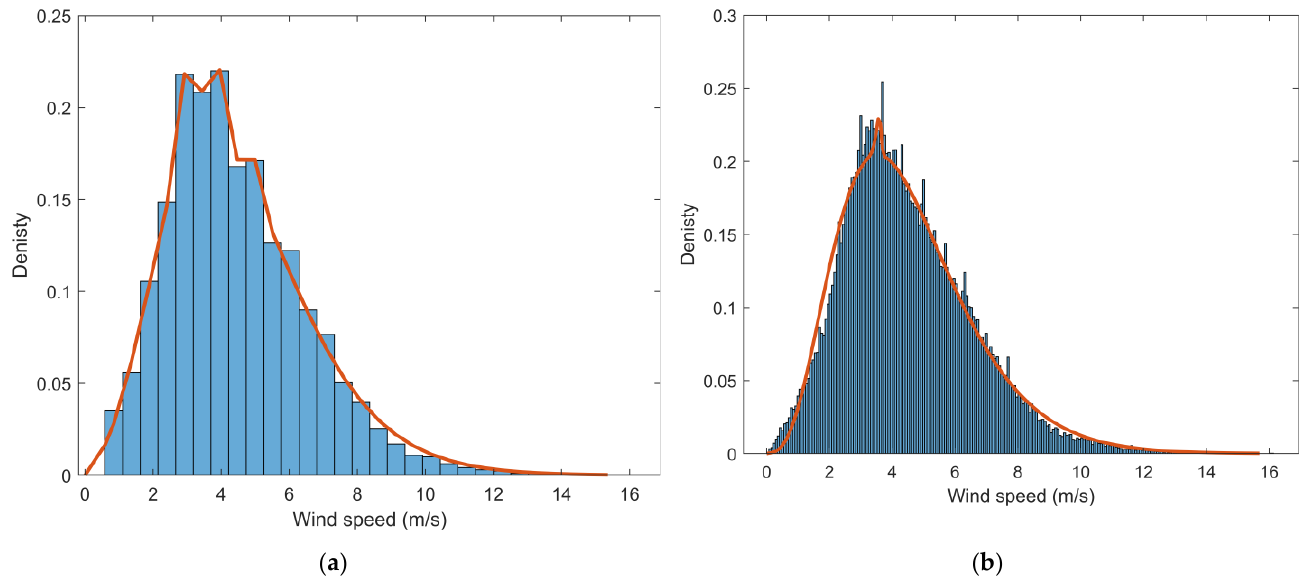
Figure 6. Fitting wind data of Site 4 to 𝑓 𝑚𝑖𝑥 using MOPSO: ( a ) 30 equal wind speed spacings; ( b ) variable wind speed spacings.